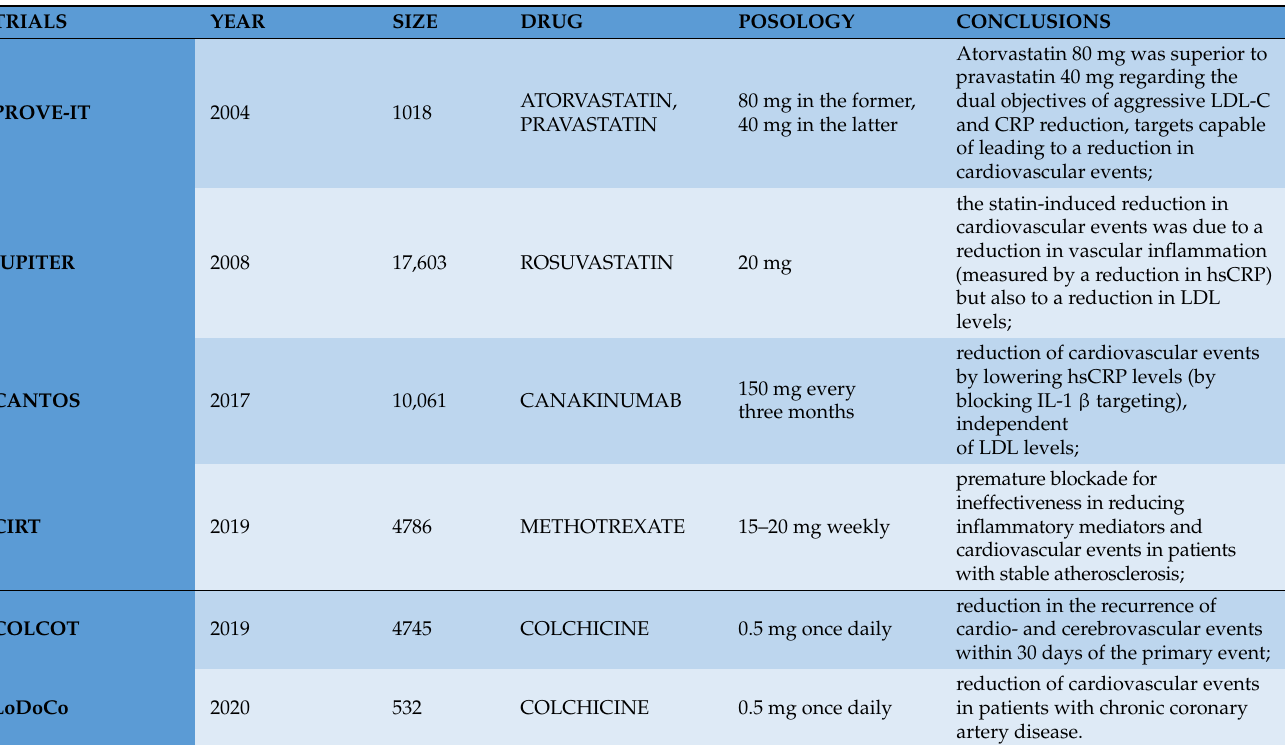
Table 1. Summary of trials that have evaluated the use of anti-inflammatory drugs with a summary of the results of each, a prerequisite for the future of scientific